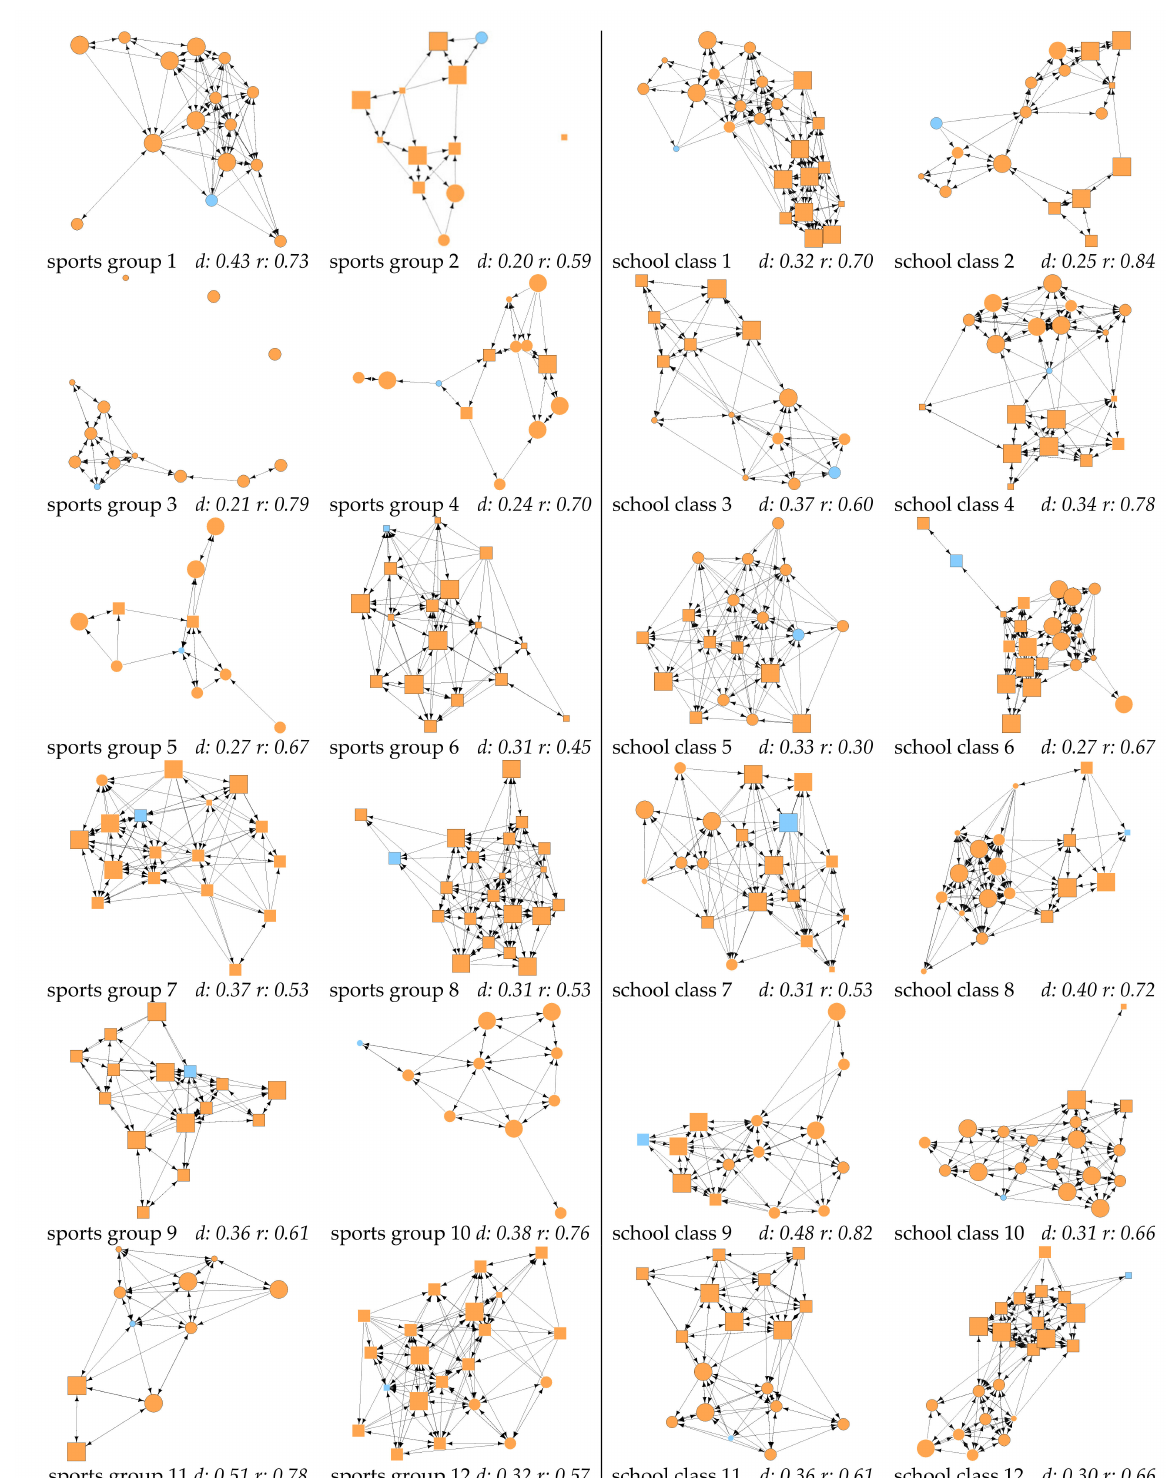
Figure 1. Friendship networks in integrative organized sports and school. Square = boy; circle = girl; blue = child with ID; orange = child without ID; node size = athletic ability; black border = speaks Swiss-German or German at home; no border = other languages; ties = friendship